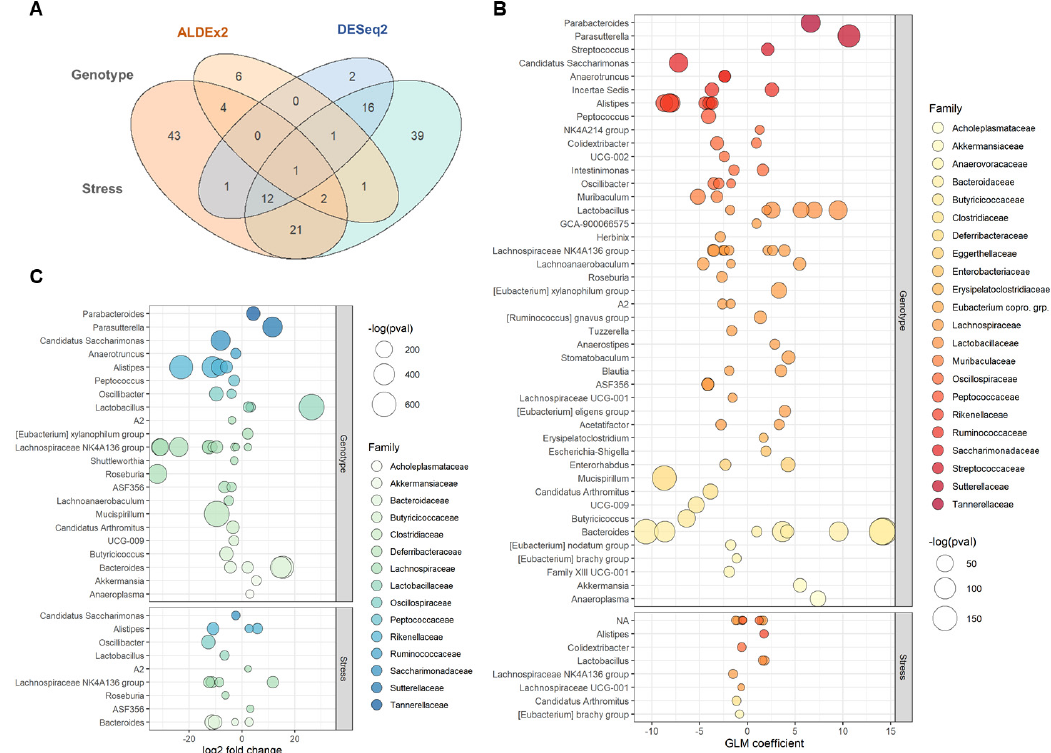
Figure 5. Differential abundance (DA) analysis reveals taxa that vary significantly between genotypes and stress conditions. ( A ) Venn diagram of consensus analysis between multiple DA analysis methods (DESeq2 and ALDEx2) showing overlap between significantly variable taxa across stress conditions (top) and genotypes (bottom). ( B , C ) Differentially abundant taxa significant to a 0.05 level using ALDEx2 (orange) and DESeq2 (blue) between genotype groups (top) and stress conditions (bottom). Positive log 2 fold change/GLM coefficient indicates higher abundance in TCR β -/- δ -/- mice compared to B6 controls and vice versa for negative fold